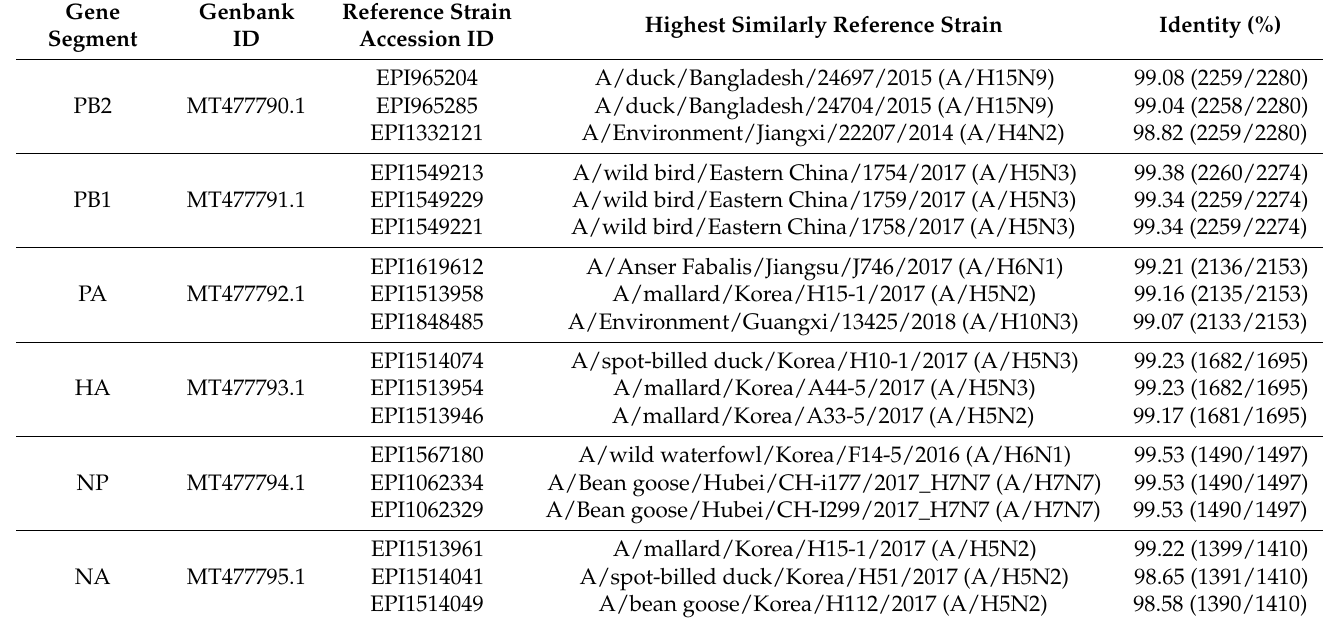
Table 2. Sequence homology of the whole A/Bean Goose/South Korea/KNU18-86/2018 (A/H5N2) genome.